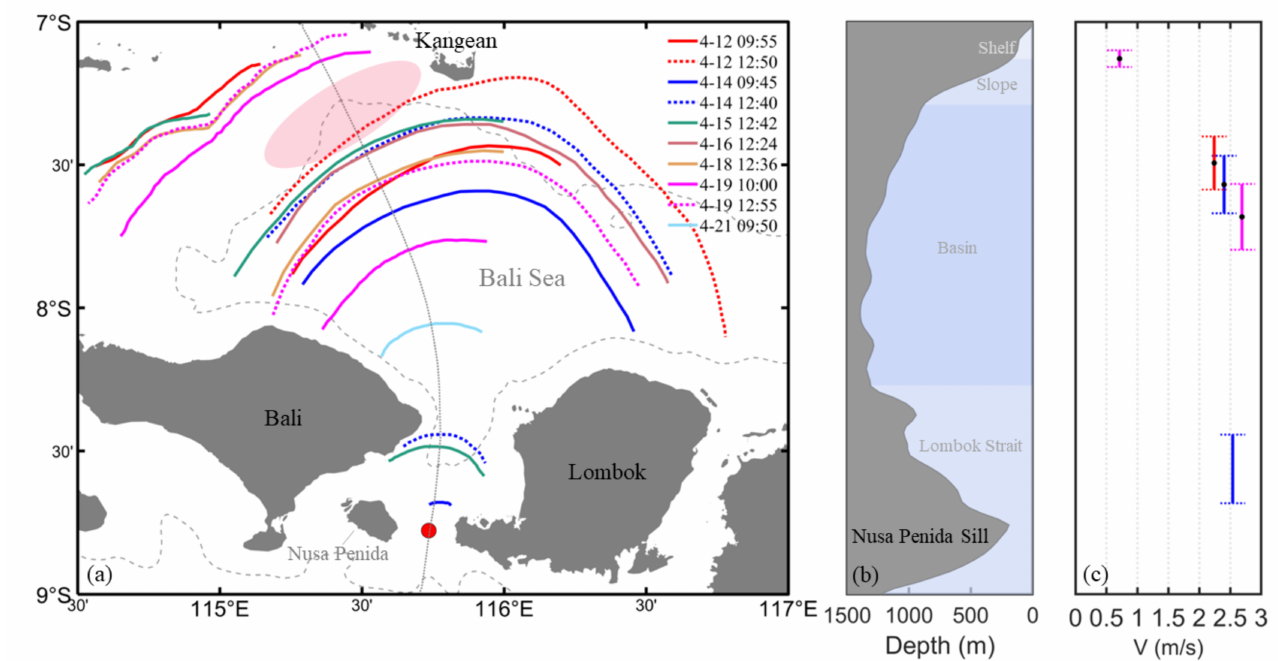
Figure 3. ( a ) The colored curves are crests of all leading ISWs in Figures 1 and 2. Gray dotted line is the 850 m isobath. The propagation path of ISWs and their generation site are plotted by thin gray line and a red dot, respectively. The pink ellipse marks the approximate area of the submarine wreck inferred from the reported information. ( b ) Bathymetry along the ISWs propagation path. ( c ) The average propagation speed between two points. Different colors correspond to ISWs in ( a